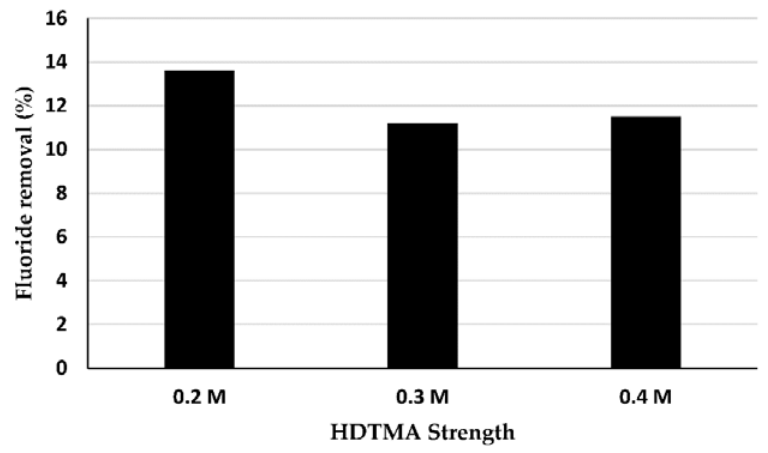
Figure 1. Plot of fluoride removal against hexadecyltrimethylammonium bromide (HDTMA) strength.